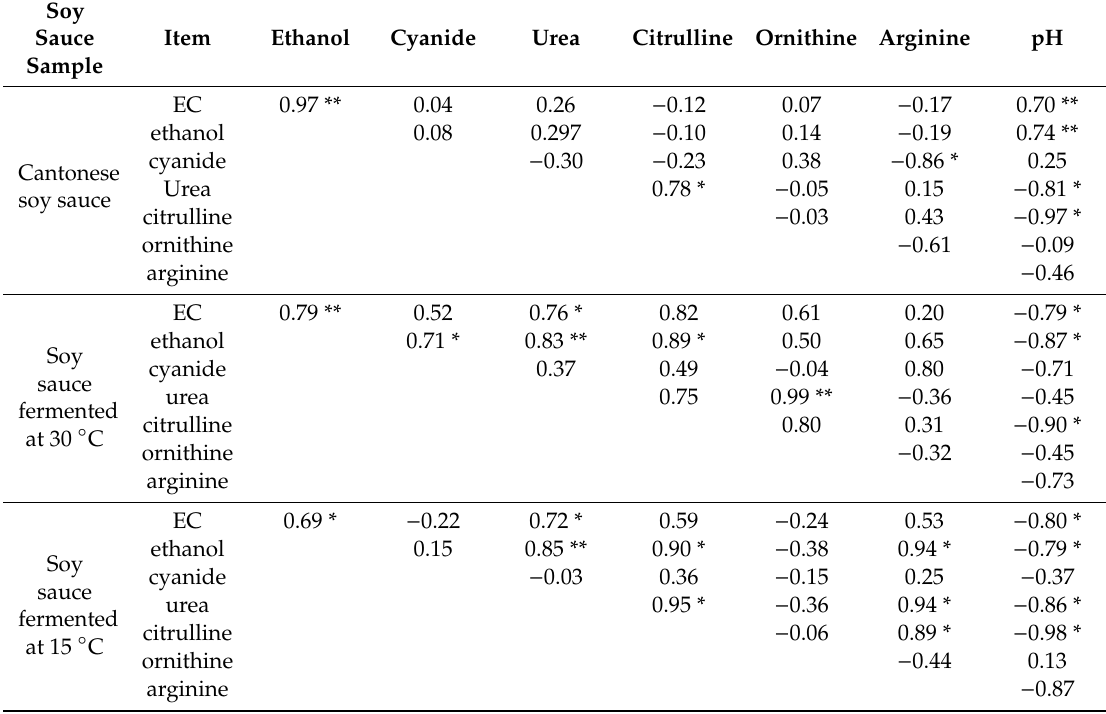
Table 3. Correlation coe ffi cients between EC, alcohol, cyanide, urea and three kind of free amino acid in each soy